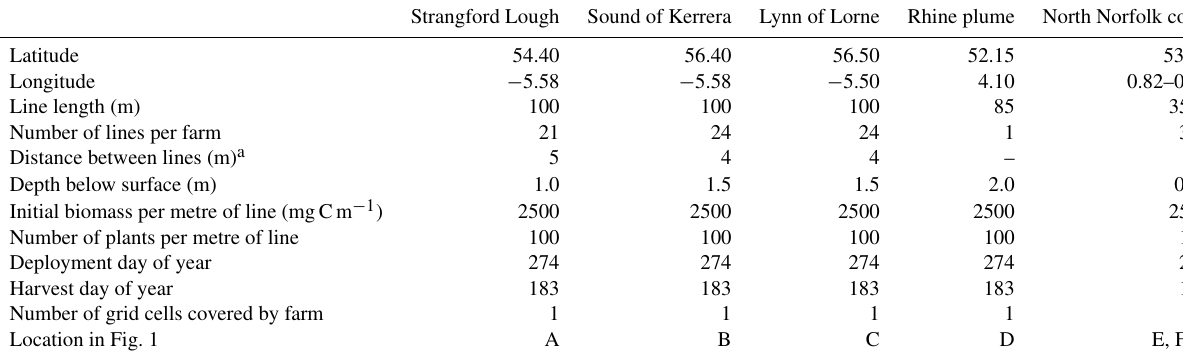
Table 4. Farm parameters as used in the model.